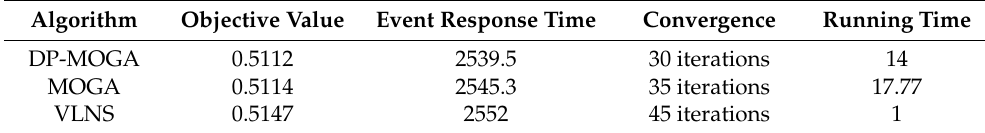
Table 3. Comparisons of experimental results.